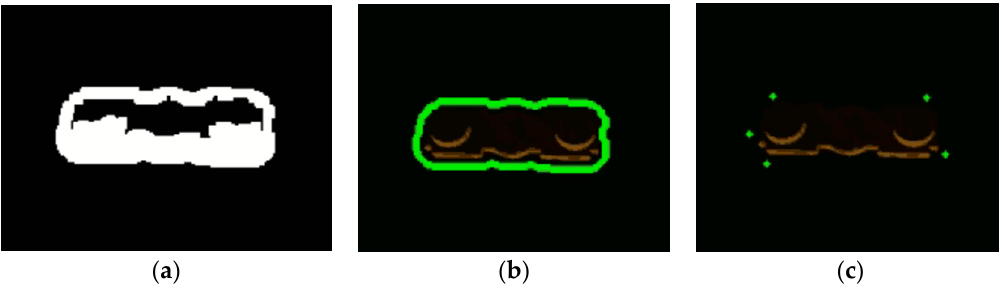
Figure 11. OpenCV detected contour representation: ( a ) binarized image; ( b ) all detected points; ( c ) reduced number of points optimized by Douglas-Peucker algorithm.